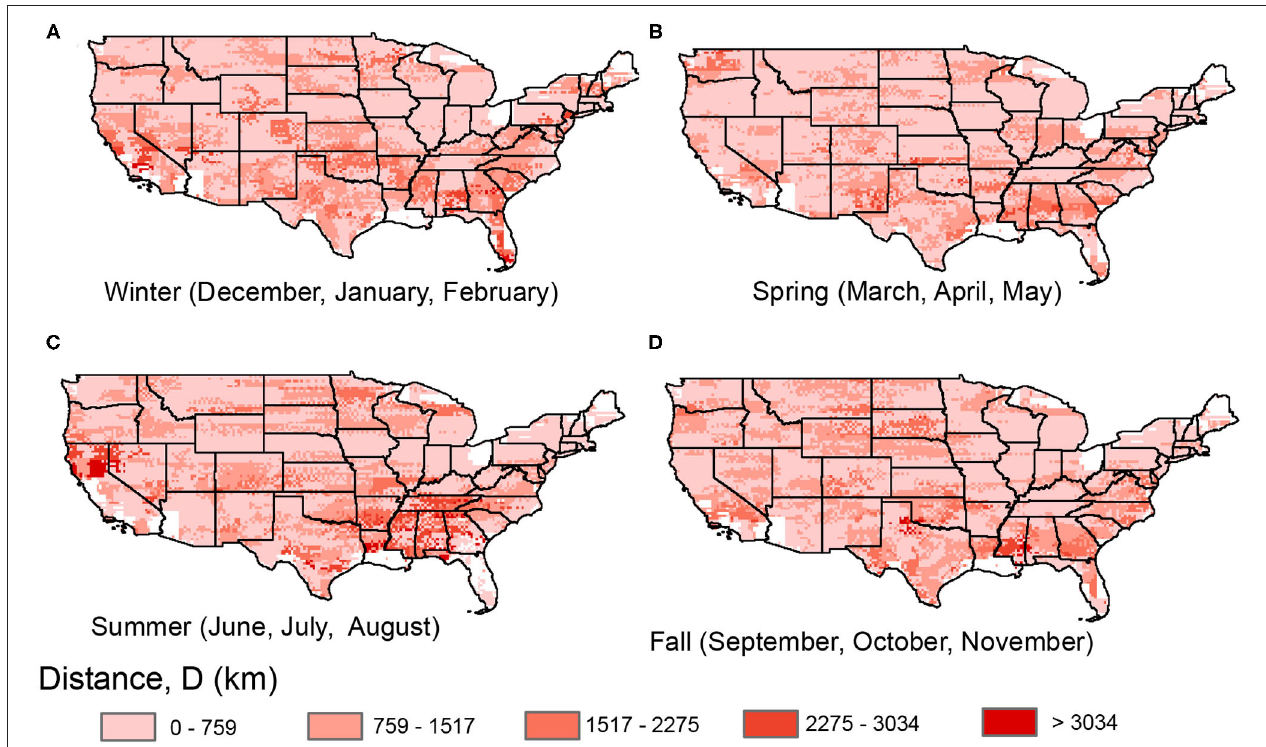
FIGURE 6 | Distance from central to end point ( D , km) for precipitation chains for (A) winter, (B) spring, (C) summer, and (D)